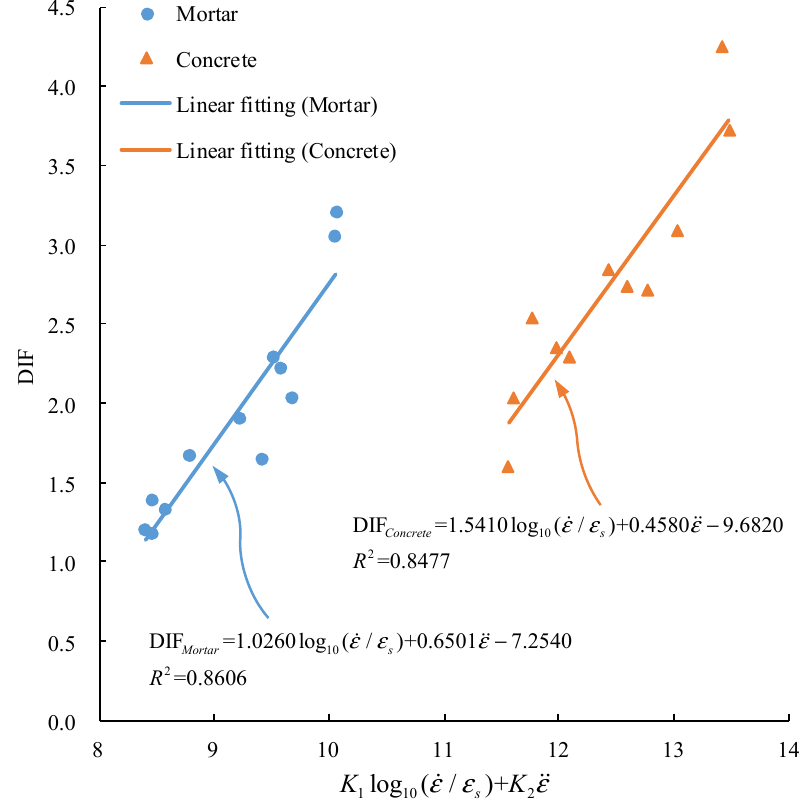
Figure 9. Variation of DIF with the logarithm of strain rate and strain acceleration.